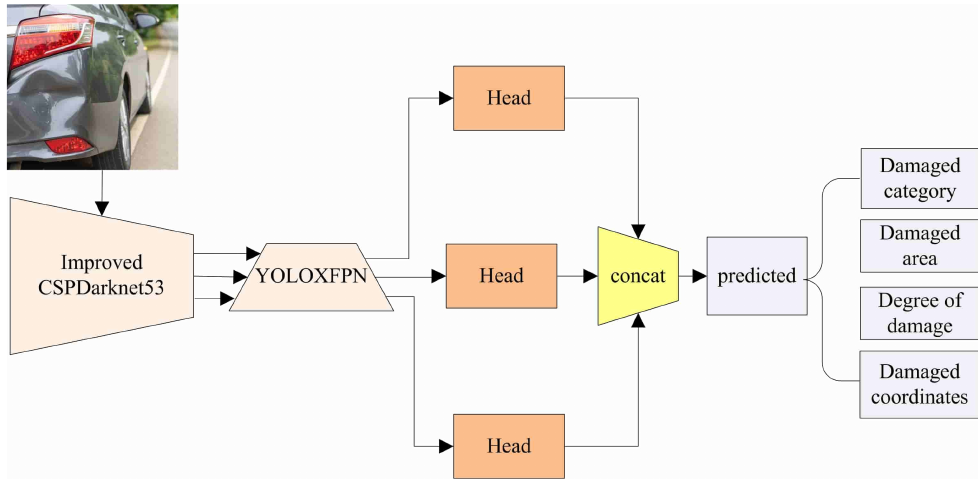
Figure 15. Damaged area inspection